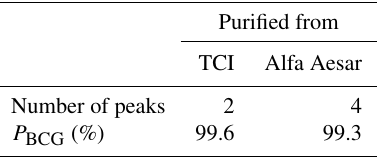
Table 2. Summary of analytical HPLC of unpurified BCG from dif- ferent vendors.